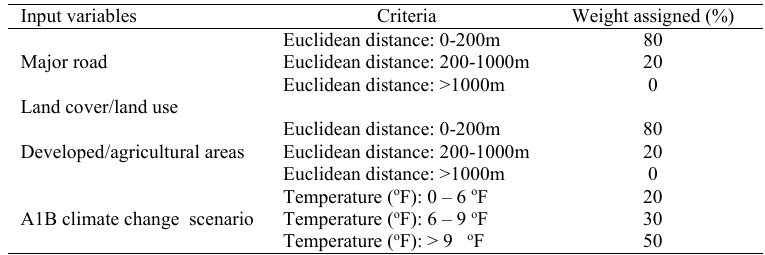
Table 2: Weights assigned to input variables used in modeling inland wetland vulnerability